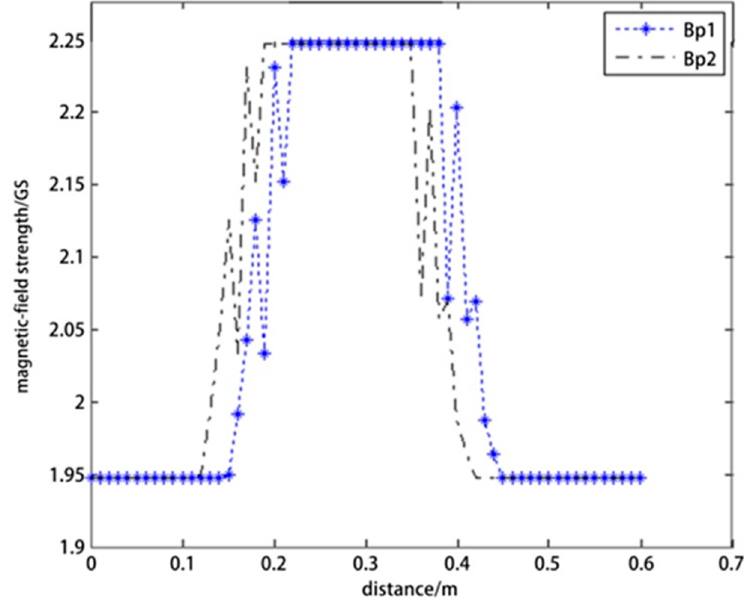
Figure 14. Magnetic-field strength measured by magneto resistive sensors A and B.